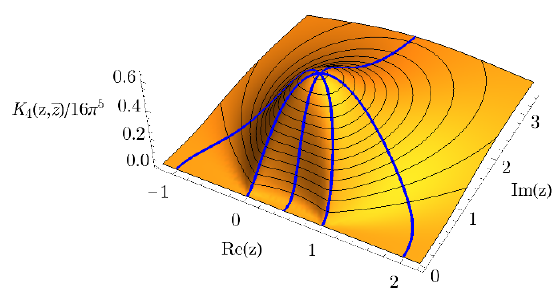
Figure 1 . The integration kernel function K 4 in d = 4 in the complex z plane. The blue lines separate regions related by crossing-symmetry. The maximum of K 4 occurs at the completely crossing-symmetric point u = v = 1.